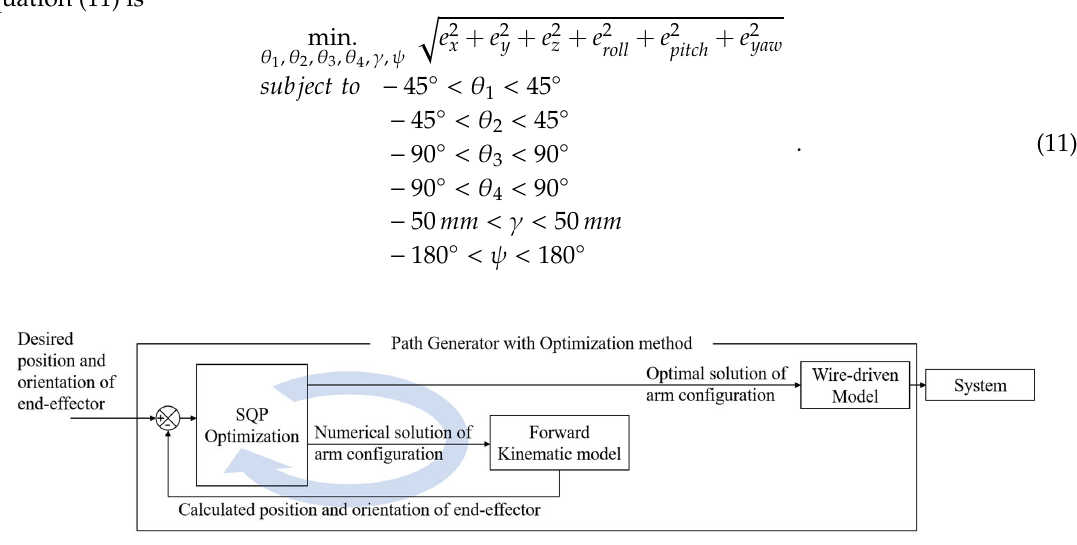
Figure 10. Block diagram of the open-loop control via the optimization path generator.